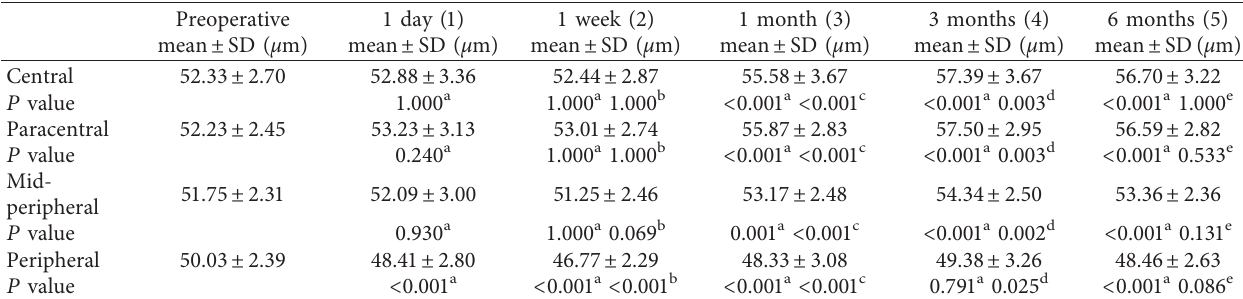
Figure 2: Preoperative to six-month postoperative epithelial thickness changes, in the central (2mm), paracentral (2 to 5 mm), mid- peripheral (5 to 7mm), and peripheral zones (7 to 9mm). The average ETof the central, paracentral, and mid-peripheral zones significantly increased from one week to three months and stabilized from three months and six months. The average ETof peripheral zone decreased at one day, one week, and six months and underwent an increase from one week to three months ( n � 64 eyes). Table 3: Epithelial thickness changes in central, paracentral, mid-peripheral, and peripheral zones over time.